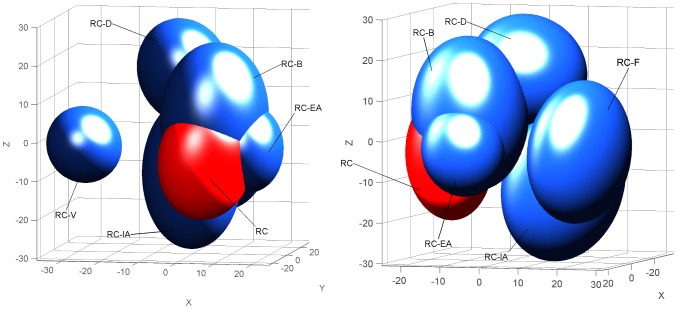
Human perception of the RC vs. RC-X mixtures.3D representation (2 different views) of the sensory map obtained from the free sorting task FS3 based on the sorting, by human adults, of the RC mixture and 6 RC-X mixtures (formulated as the RC mixture but deleted of one component). The map was drawn using a non-metric MDS analysis. Ellipsoids represent 95% confidence intervals and were calculated using a bootstrap algorithm.